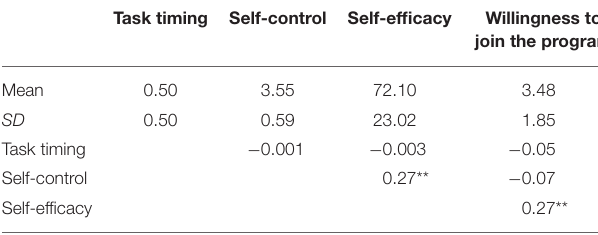
Task timing Self-control